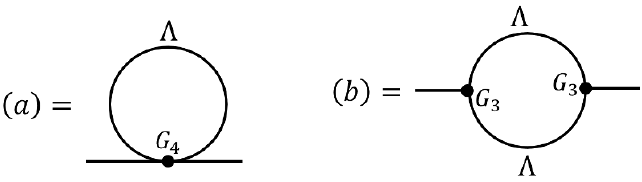
Figure 4. Diagrams contributing to the beta function of ˜ ω at order 1 /N